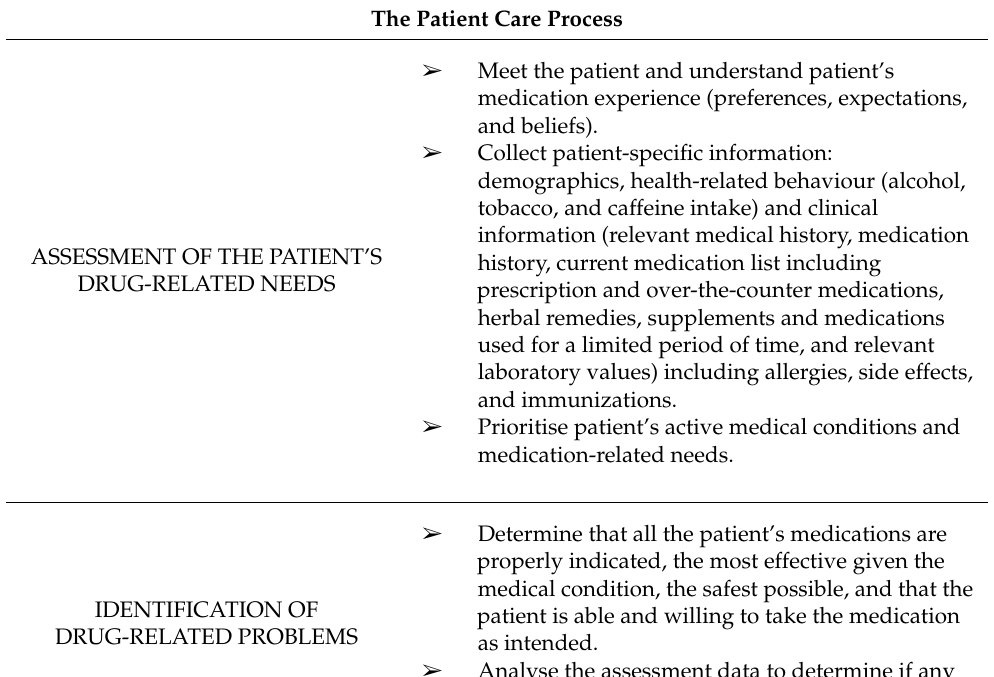
Table 1. Standardised CMM activities in the patient care process